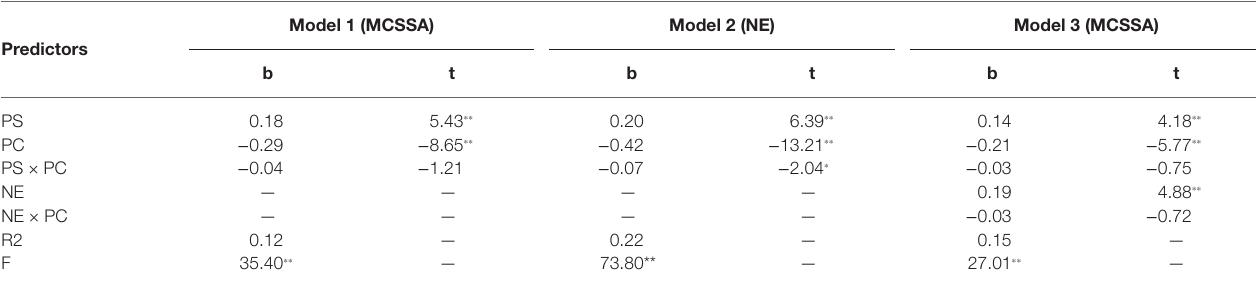
TABLE 3 | Testing the moderated mediation effect of perceived stress on medical college student smartphone addiction.